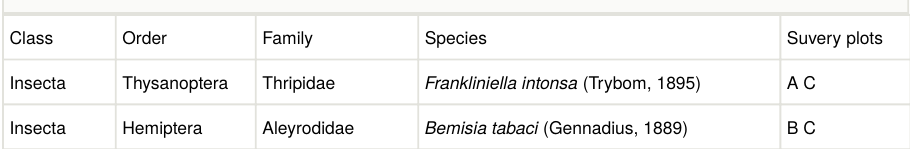
Table 2. List of insect and mite pests found on pepino plants in the Atsugi Campus of Tokyo University of Agriculture (TUA), Kanagawa,